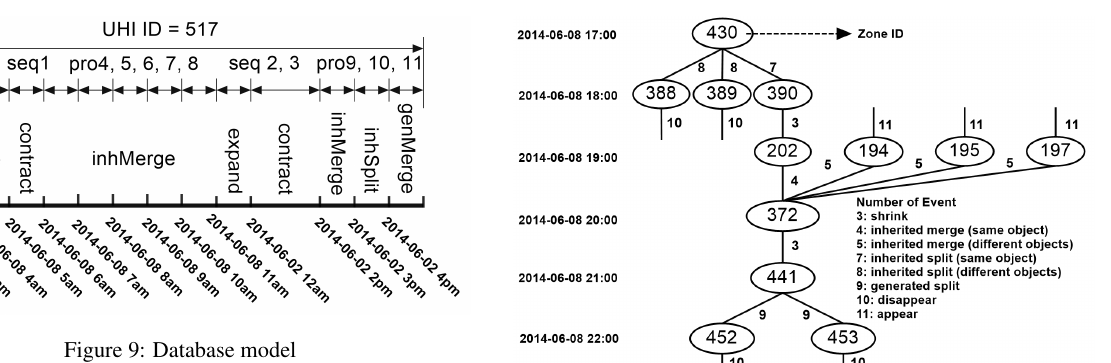
Figure 11: Evolution of an urban heat island at six consecutive time instants